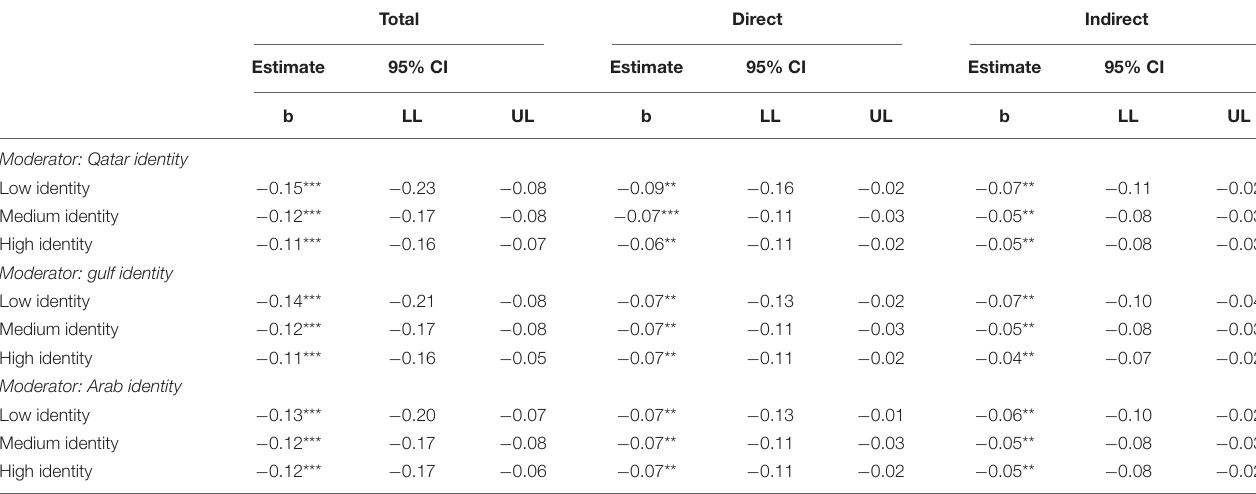
TABLE 3 | Unstandardized estimates and 95% confidence intervals of the total, direct, and indirect, effects of perceived threat on well-being via self-esteem, at different levels of each facet of social identity